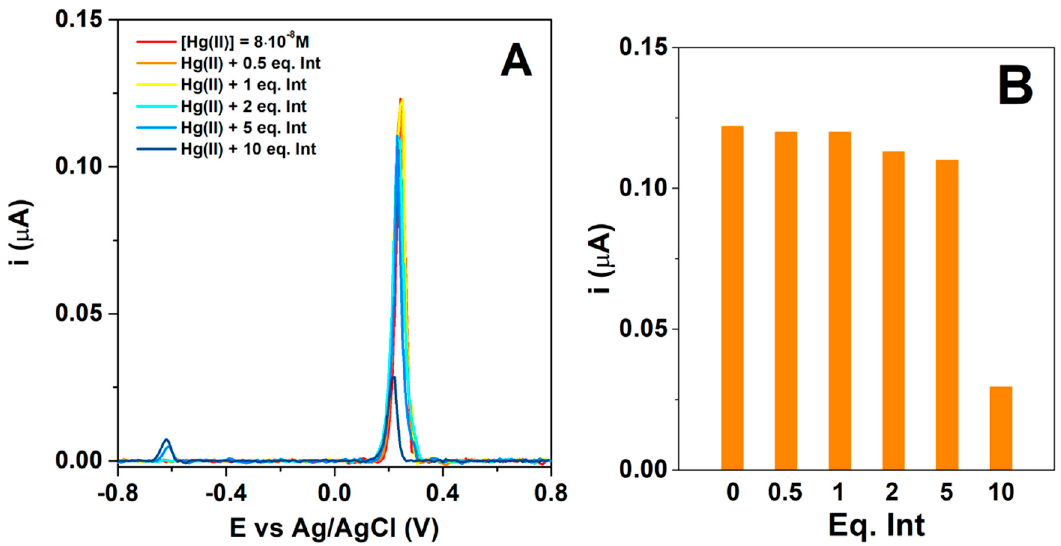
Figure 9. DPV curves (background corrected) recorded on a GC | click | L modified electrode ( A ) and Hg(II) stripping current intensity ( B ) in the presence of a mixture of interfering ions.